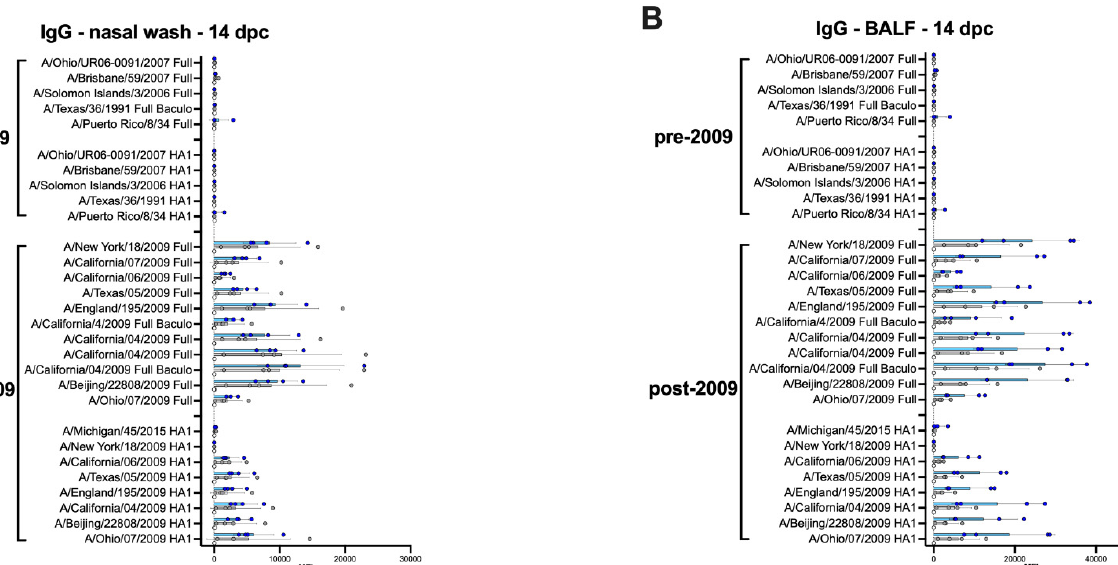
Figure 8. Mucosal IgG and IgA responses 14 dpc in IGIP-H1att- and H1caLen-vaccinated mice. Mice ( n = 4/group) were humanely euthanized at 14 dpc, and nasal washes ( A , C ) and BALFs ( B , D ) were collected to evaluate the levels of IgG ( A , B ) and IgA ( C , D ) antibodies against H1 HAs on the protein microarray. The reactivity of samples in main graphs and insets is expressed as described in Figure 4 and results shown as MFI ± SD. The statistically significant differences between IGIP-H1att and caLen are depicted with red asterisks. 3.6. Humoral and Mucosal Responses against the NA and Internal Proteins Are Consistent with Anti-HA Response Patterns in the IGIP-H1att and H1caLen Groups The serum and mucosal IgG and IgA profiles against the NA, NP, M1 and NS1 fol- lowed the patterns observed against HA responses (Figures 9 and 10). Anti-NA responses were, on average, clearly above background at 20 dpb, but only in serum samples from the IGIP-H1att group and they were largely directed to the N1 subtype (Figure 9A), whereas those from the H1caLen had background responses. Anti-NA responses, specif- ically against N1, increased in the IGIP-H1att serum samples but not in those from the H1caLen group at 14 dpc and was statistically significant (Supplementary Figure S1I).